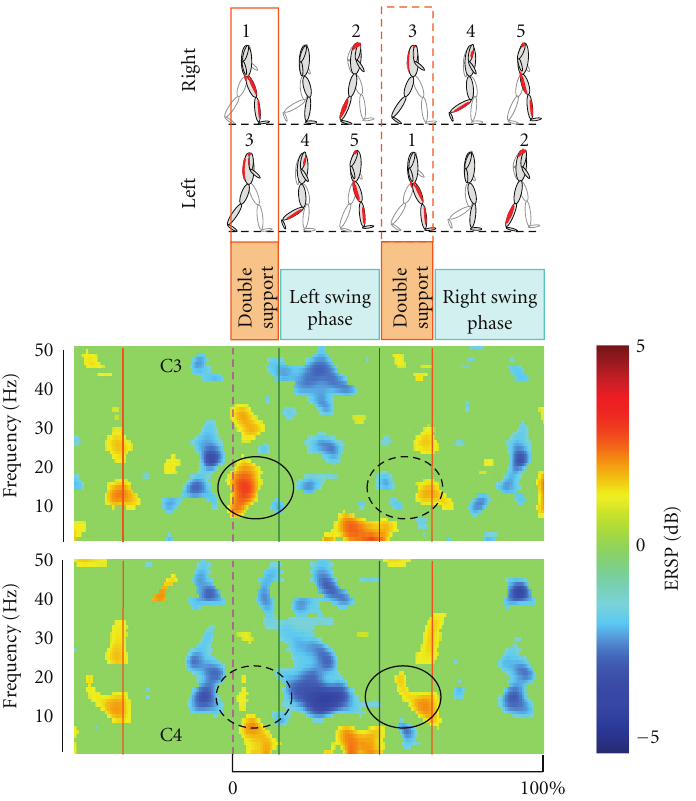
Figure 5: Event-related spectral perturbation (ERSP) during walking cycle recorded in C3 and C4 electrodes for one subject. The stripped lines indicate the right heel strike event upon which the averaging was triggered. The power increase is represented in red color and the power decrease in blue